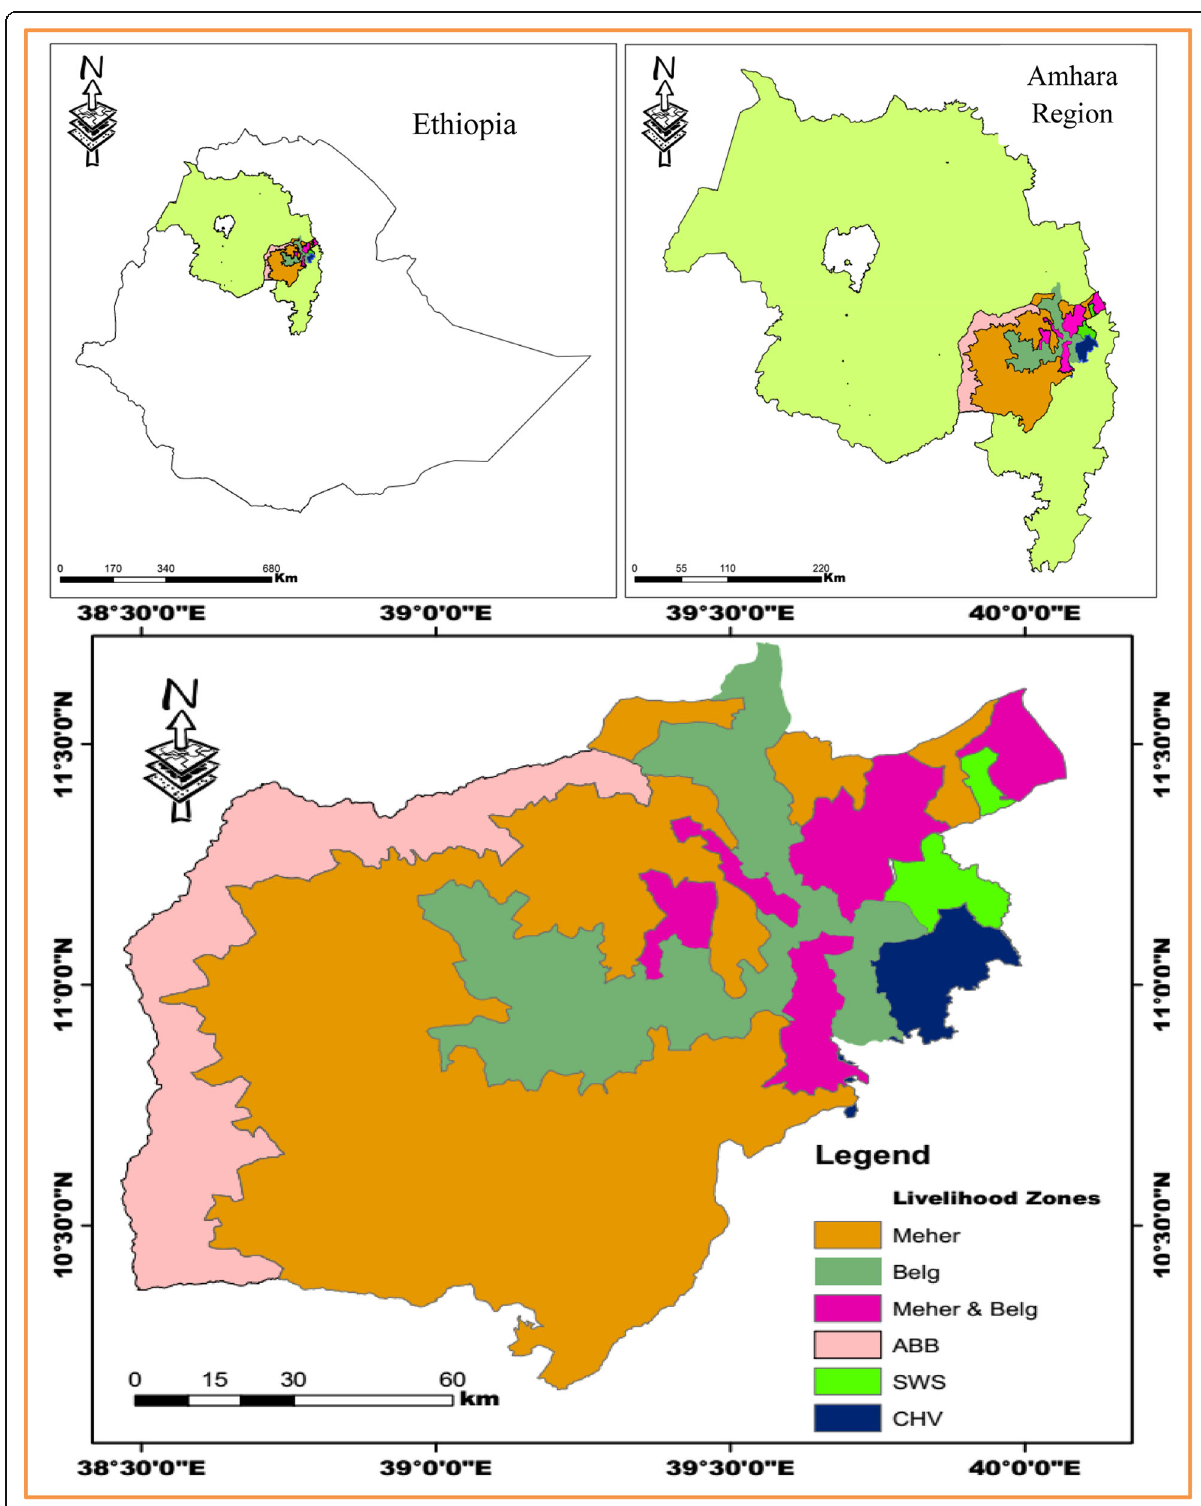
Fig. 2 The relative location and livelihood zone classifications of South Wollo administrative